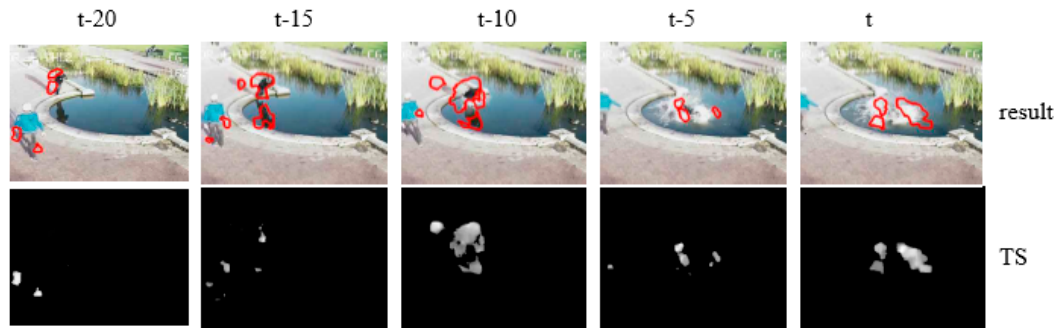
Figure 15. Examples of detection results for abnormality from the No. 8 data.